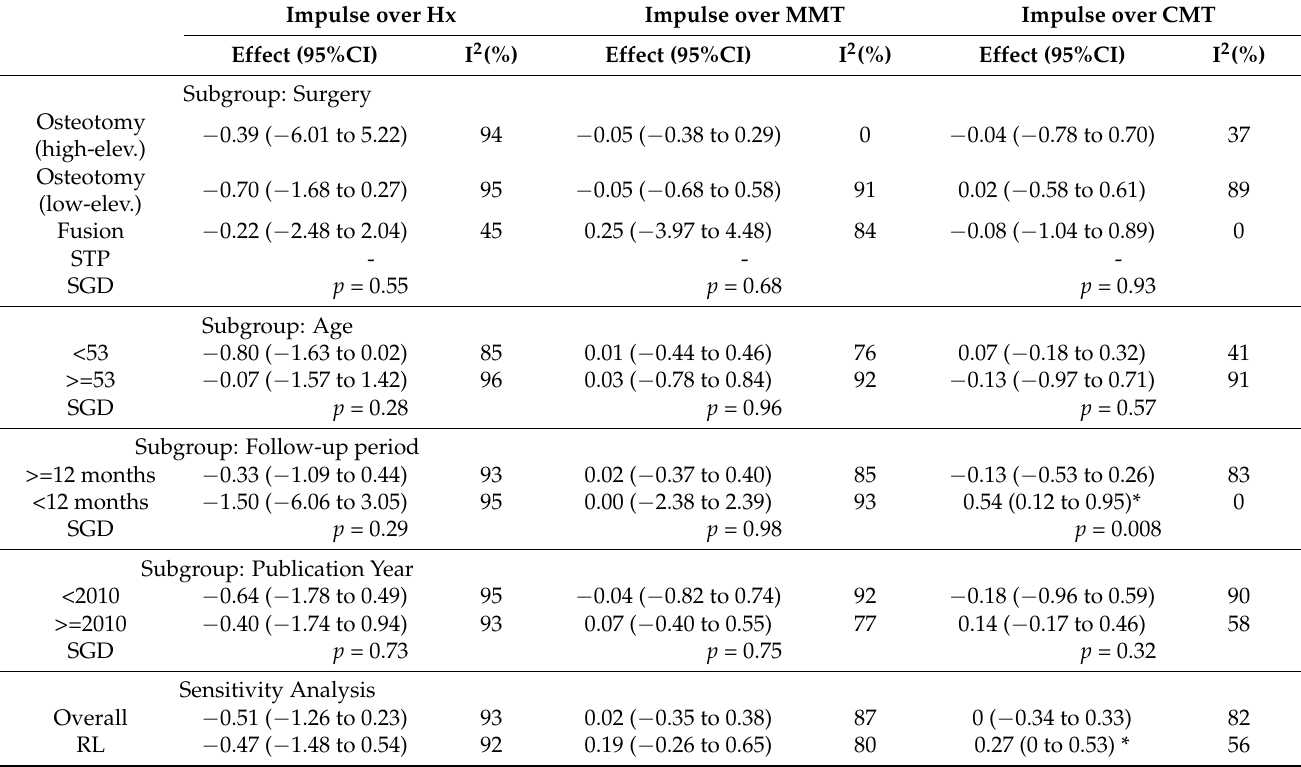
Table 4. Subgroup and sensitivity analysis of the meta-analysis on impulse